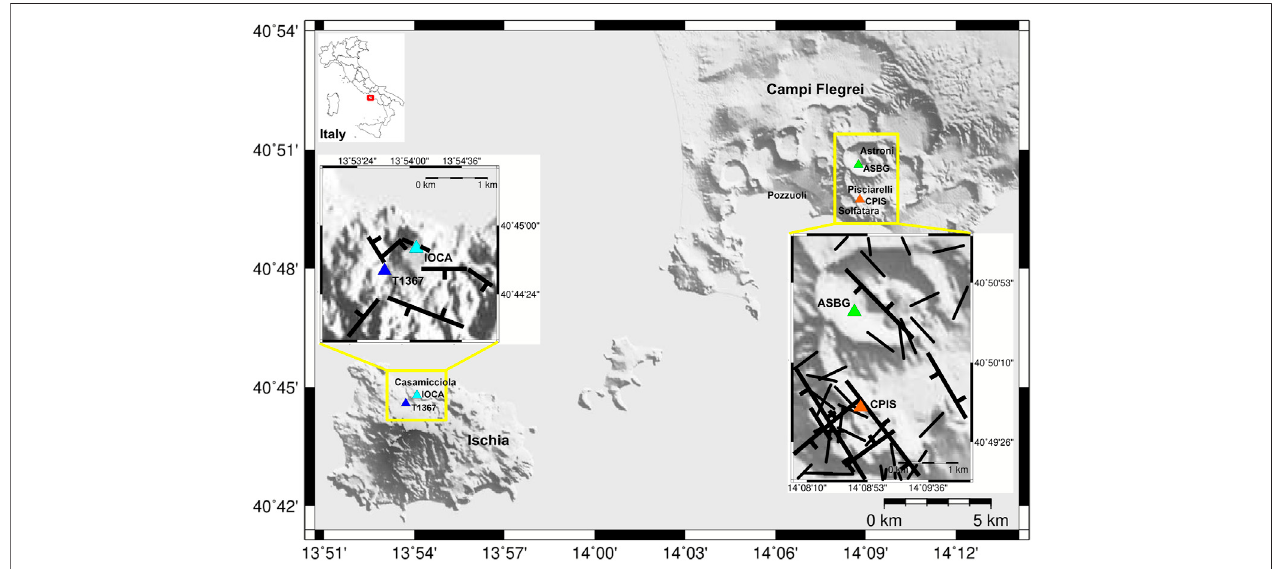
FIGURE 1 | The studied areas (indicated by the red box on the map in the upper left corner) with the location of the seismic stations (triangles). The two insets corresponding to yellow boxes show the fault (black half-tick lines) and fracture distributions (black lines) at Campi Flegrei (Vitale and Isaia, 2014) and Ischia island (Di Giuseppe et al.,